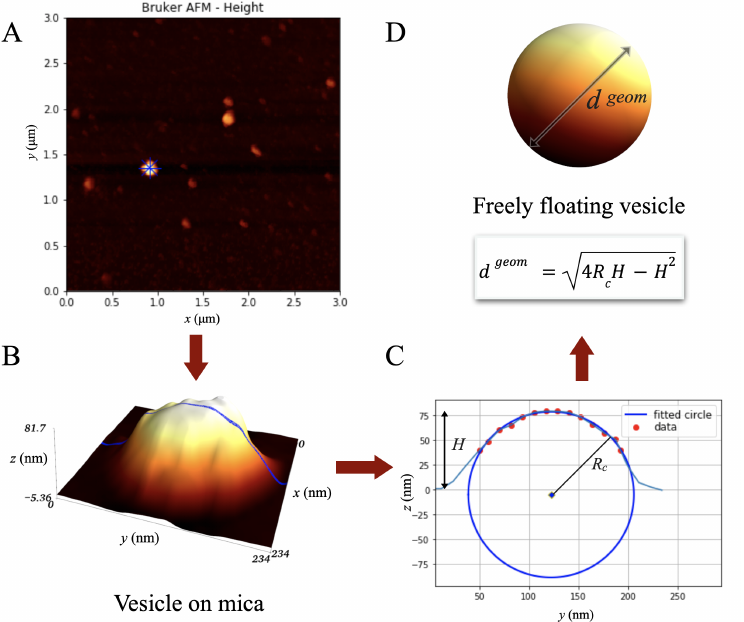
Figure 7. Scheme of AFM data analysis using AFM height mode images: ( A ) an exemplary AFM image (blue lines indicate directions of four profiles chosen for the selected vesicle); the height above the surface is coded with the heat colormap; ( B ) the selected exosome height is shown in 3D; one of the selected profiles is represented by the blue line; ( C ) the result of fitting a circle to the upper part of the selected profile; ( D ) evaluation and visualization of a freely floating vesicle with diameter d geom based on the fitted R c